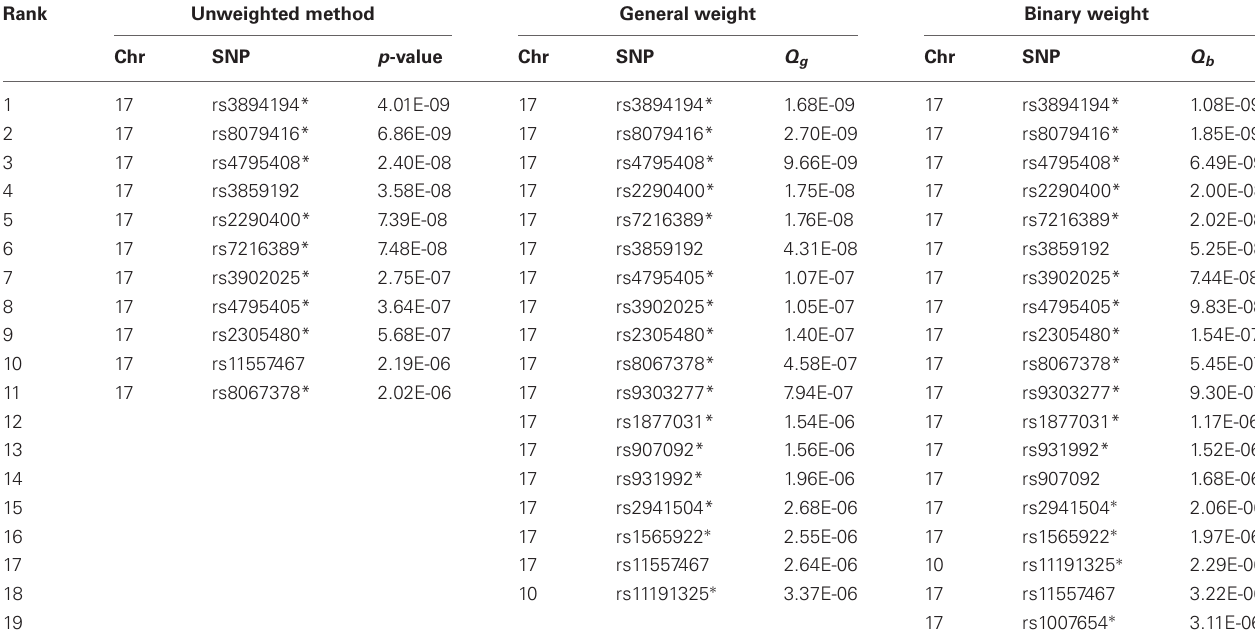
The BH procedure is used with an FDR level of 0.05. *